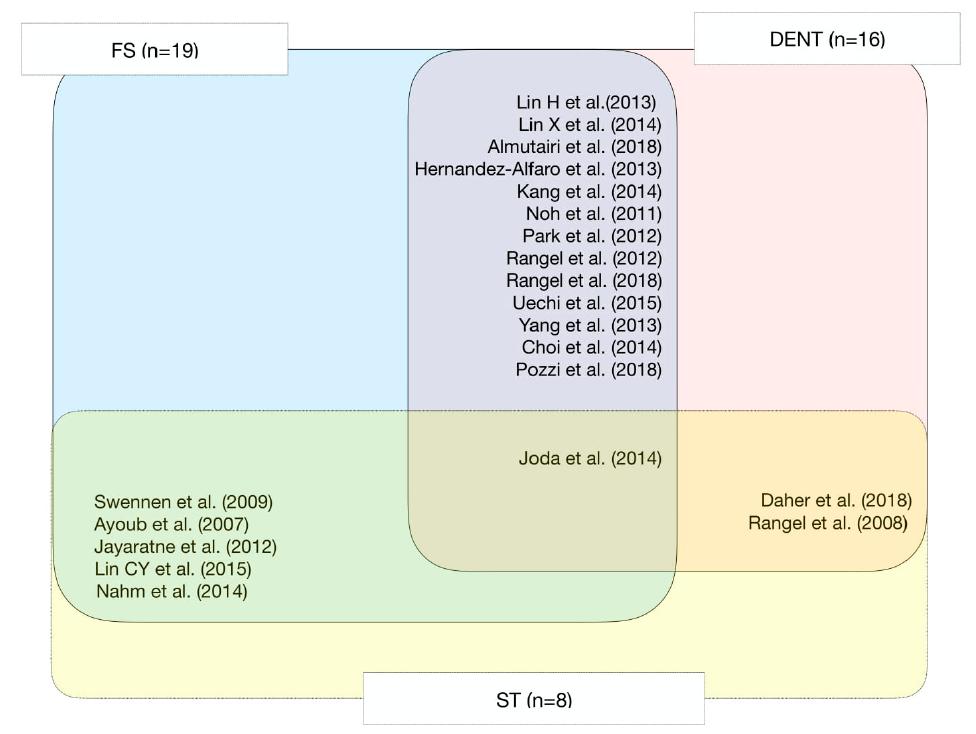
Figure 3. Summary of the included studies.